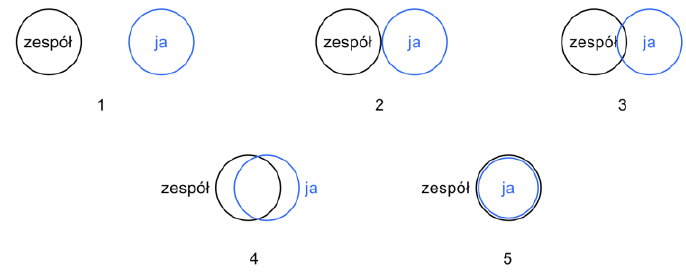
Figure 2. Graphics used to assess group identification.